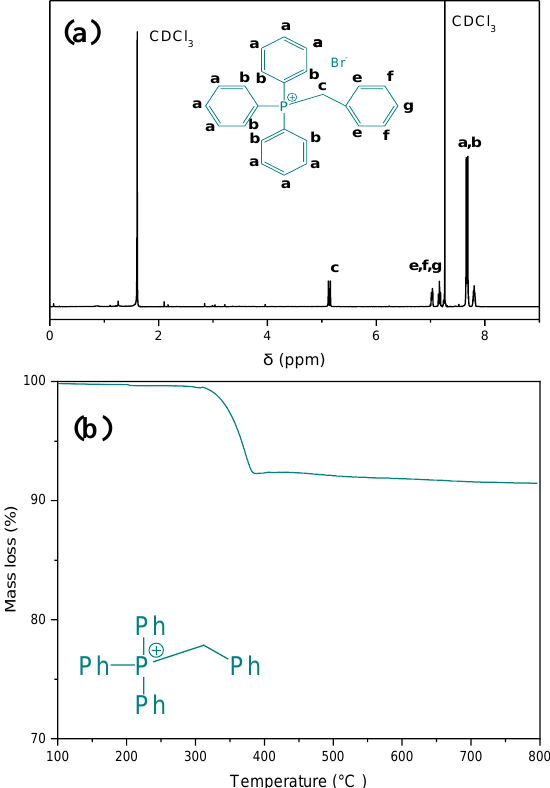
Figure 1. ( a ) 1 H-NMR spectrum and ( b ) TGA graph for the synthesized benzyltriphenylphosphonium bromide (BTPB).